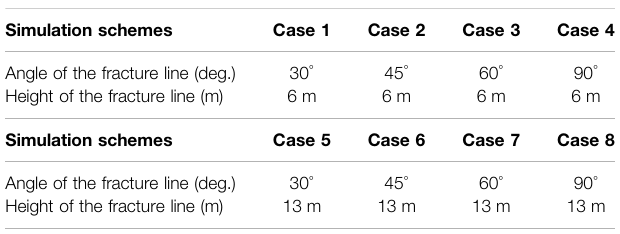
TABLE 2 | Simulation scheme parameters.